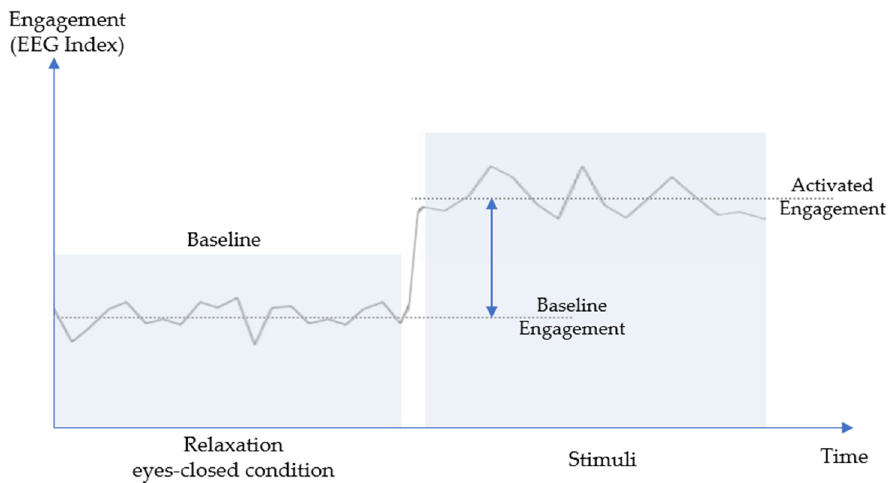
Figure 3. Engagement baseline vs. stimuli activation.